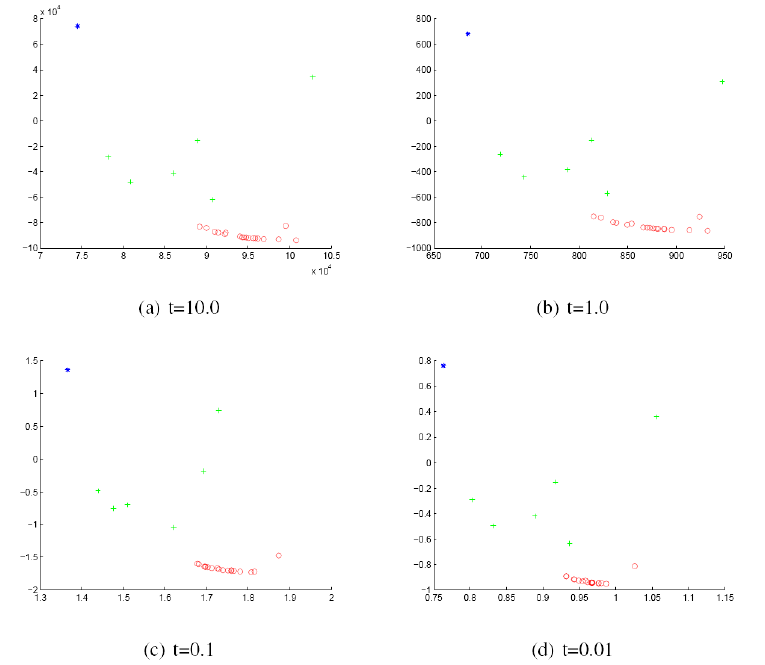
Figure 7. MDS embedding obtained using HD for COIL data represented by the Gaussian curvatures associated with each node. The x and y axes are the embedding coordinates corresponding to the leading two dimensions of the MDS embedding. The differently-coloured symbols denote different object